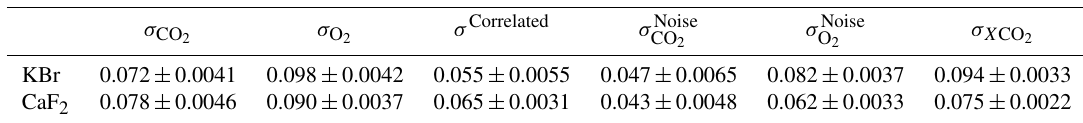
Table 5. Mean precision, noise and correlation errors (given in %) for both ensembles, of 2093 measurements each, using KBr and CaF 2 beam splitters. The X CO precision is the root-sum-square of the noise errors of CO 2 and O 2 2